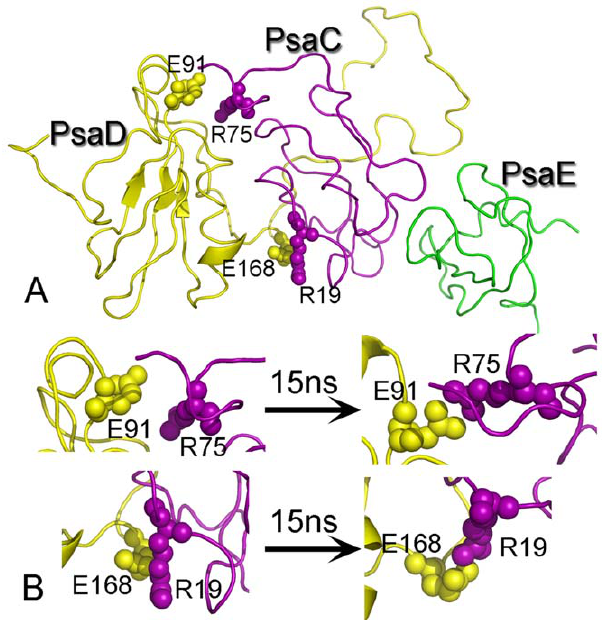
Figure 5. The modelled structure of the PsaC, PsaD and PsaE from rice ( Oryzasativa L.). A : Two important salt bridge interactions were labelled on the model. B: The conformation change of the salt bridge during the 15 ns simulation.